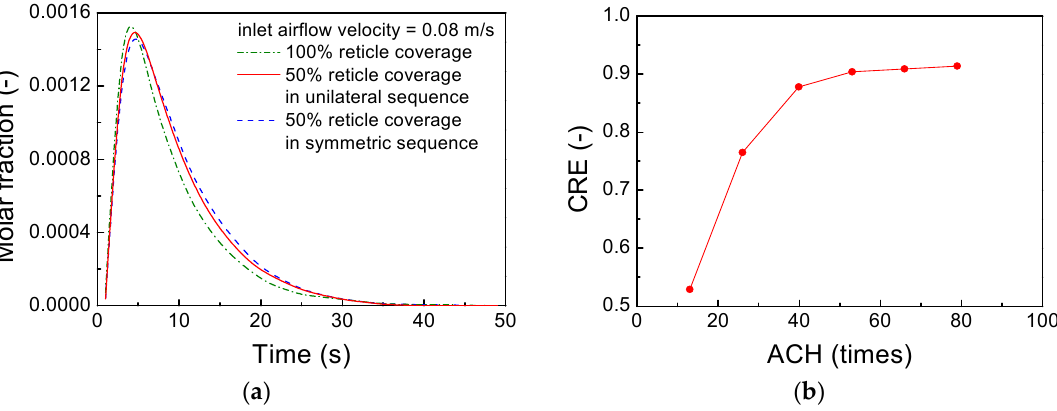
Figure 5. ( a ) Effect of the arrangement of reticle boxes on the contaminant concentration evolution at the monitoring position in the stocker; ( b ) air change per hour (ACH) related to the contaminant removal efficiency (CRE).